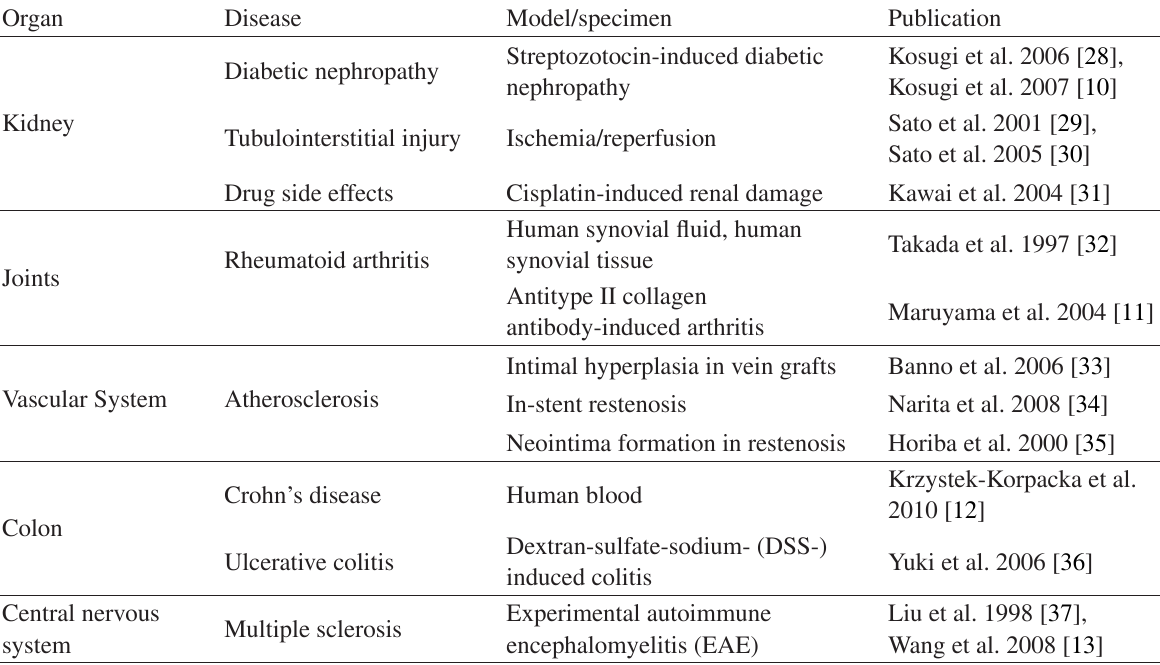
TABLE 1: Overview of the role of MK in chronic inflammatory